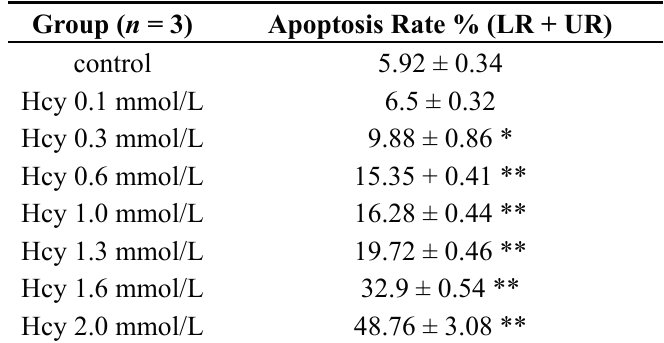
Compare to the control group, * p < 0.05, ** p < 0.01 ( n = 3 in each group); Abbreviations of the samples means: LR, Low right quadrants in the apoptosis figure of the flow cytometry, UR, Up right quadrants in the apoptosis figure of the flow